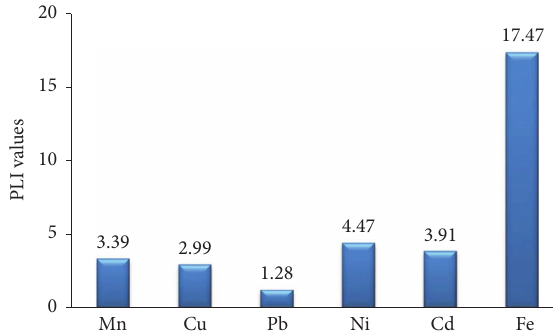
Figure 3: Pollution load index (PLI) values for heavy metals in